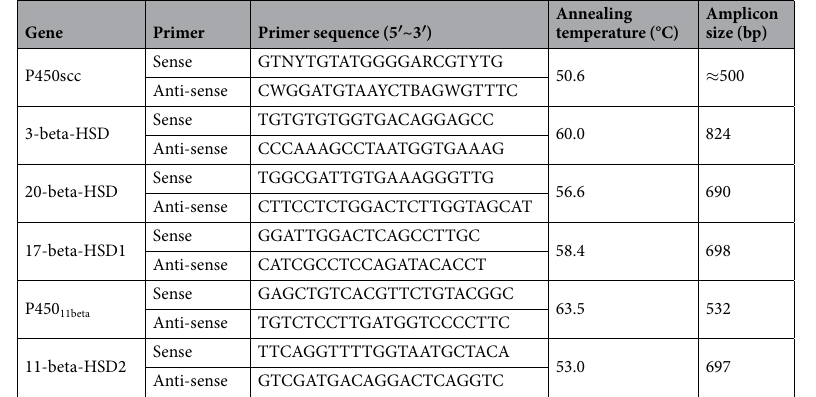
Table 2. Primers for PCR amplification. N = A/T/C/G, W = A/T.